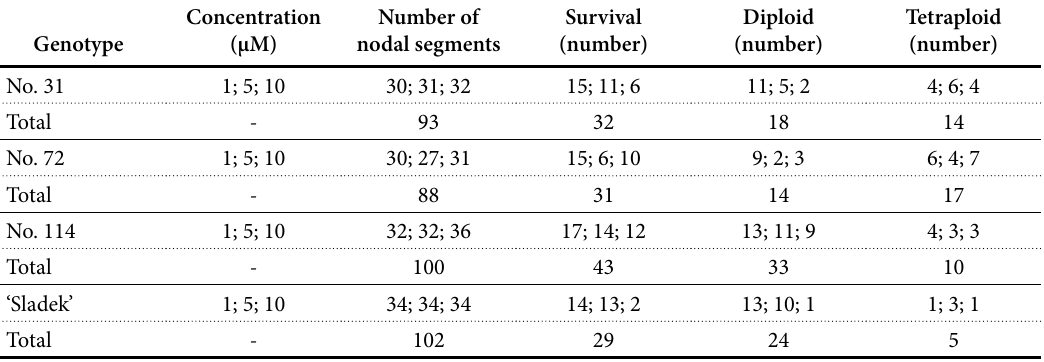
Tab. 1 Cultivation of nodal segments of Osvald’s clones and ‘Sladek’ cultivar on oryzalin medium for 2 weeks.